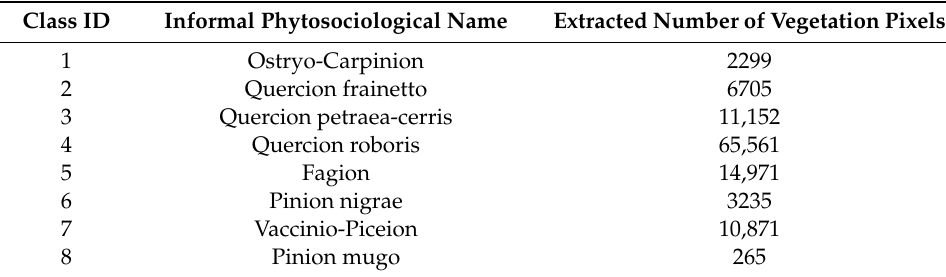
Table 2. The definition of classification scheme and the number of vectorized training polygons for their representation.